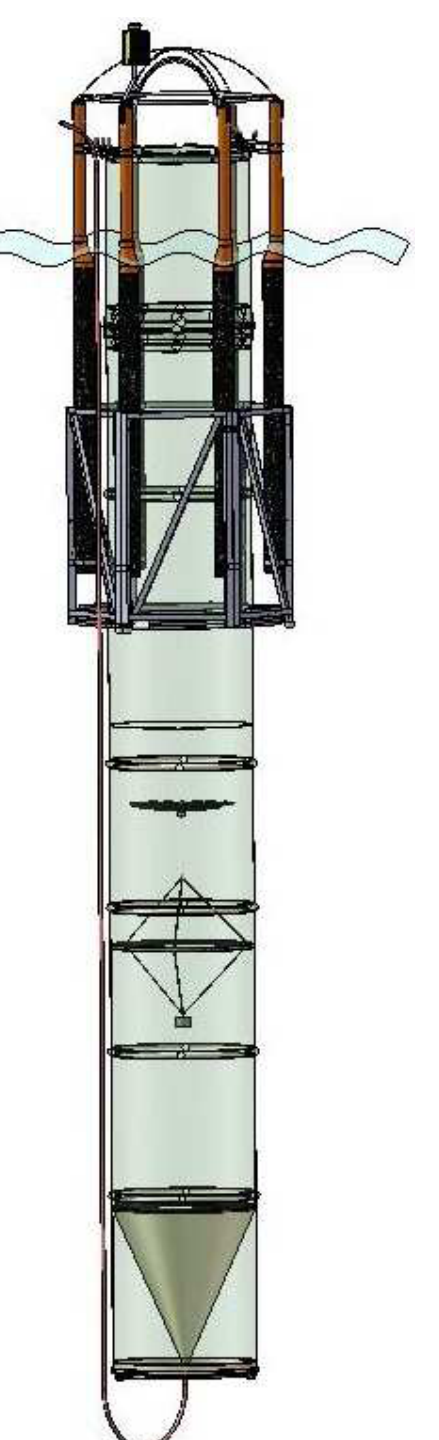
Fig. 1. Drawing of a KOSMOS mesocosm in the configuration used for the Svalbard